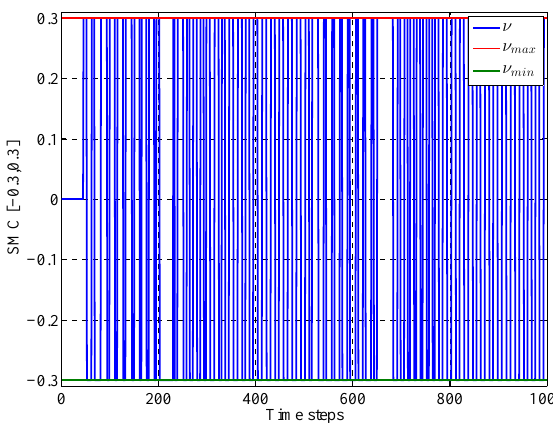
Figure 7: The angular velocity z 2 of the nominal model for the nominal MPC , and x 2 of the real plant for the proposed control